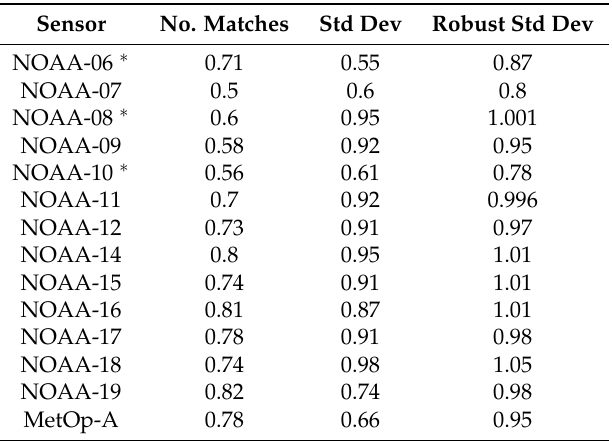
Table 7. Ratio of three-channel (3.7, 10.8 and 12 µ m) nighttime SST retrieval statistics using Bayesian and CLAVR-x cloud masks compared against drifting buoy data. Ratios are calculated using satellite minus in situ SST differences, first applying the Bayesian mask and then comparing against the same statistics with the CLAVR-x mask applied. Values less than one in each column indicate that the Bayesian mask has fewer matches, lower standard deviation or lower robust standard deviation. Sensor No. Matches Std Dev Robust Std Dev NOAA-06